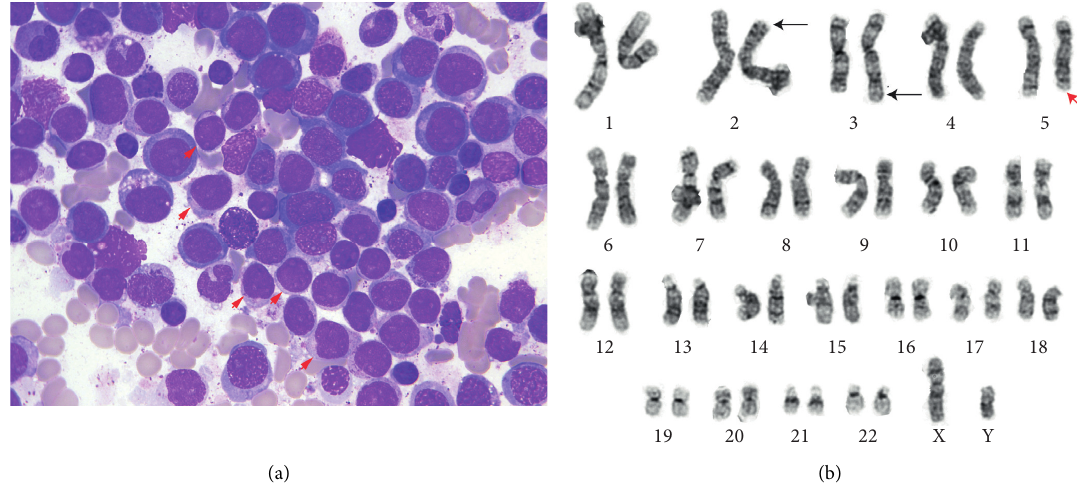
Figure 1: Bone marrow aspirate and AML cytogenetic karyotype: (a) wright-stained bone marrow aspirate showing increased blasts (examples highlighted by red arrowhead; 1000x original magnification); (b) AML karyotype demonstrating the t (2;3)(p23;q27) (black arrows) and del (5q)(q31;q33) (red